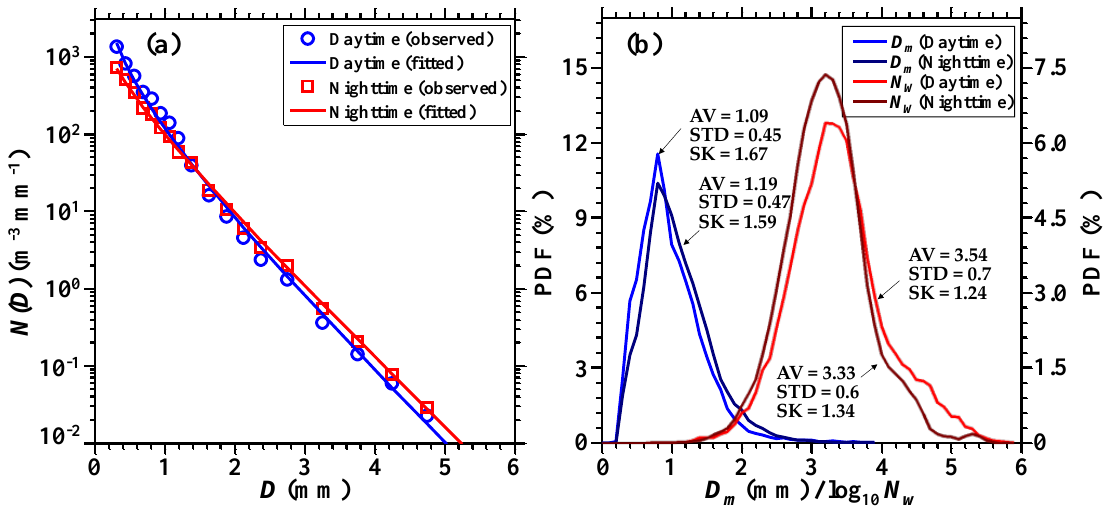
Figure 5. Composite RSDs and their fitted normalized Gamma results observed in the daytime and nighttime, respectively ( a ), and probability density distributions (PDFs) of D m (mm) and log 10 N w observed in the two periods, respectively ( b ). In subgraph ( b ), the AV, STD, and SK denote the average, standard deviation, and skewness. The unit of N w is m − 3 mm − 1 . The left and right Y-axes in ( b ) are for the D m and log 10 N w , respectively.